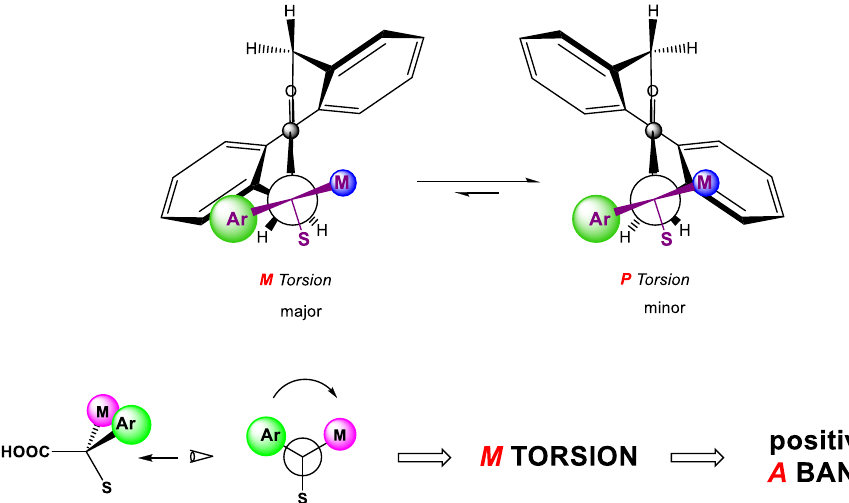
Figure 3. Top: schematic representation of the conformational equilibrium in 2-aryl-substituted bi- phenyl amides. Bottom: mnemonic scheme relating the absolute configuration and the sign of the A band in the ECD spectrum of biphenylamides. Ar = aromatic group, M = medium size group, S = smallest group. Reprinted with permission from [19]. Copyright 2006, American Chemical